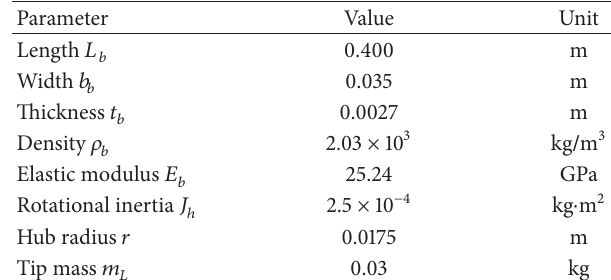
Table 3: Structural parameters of actuators.